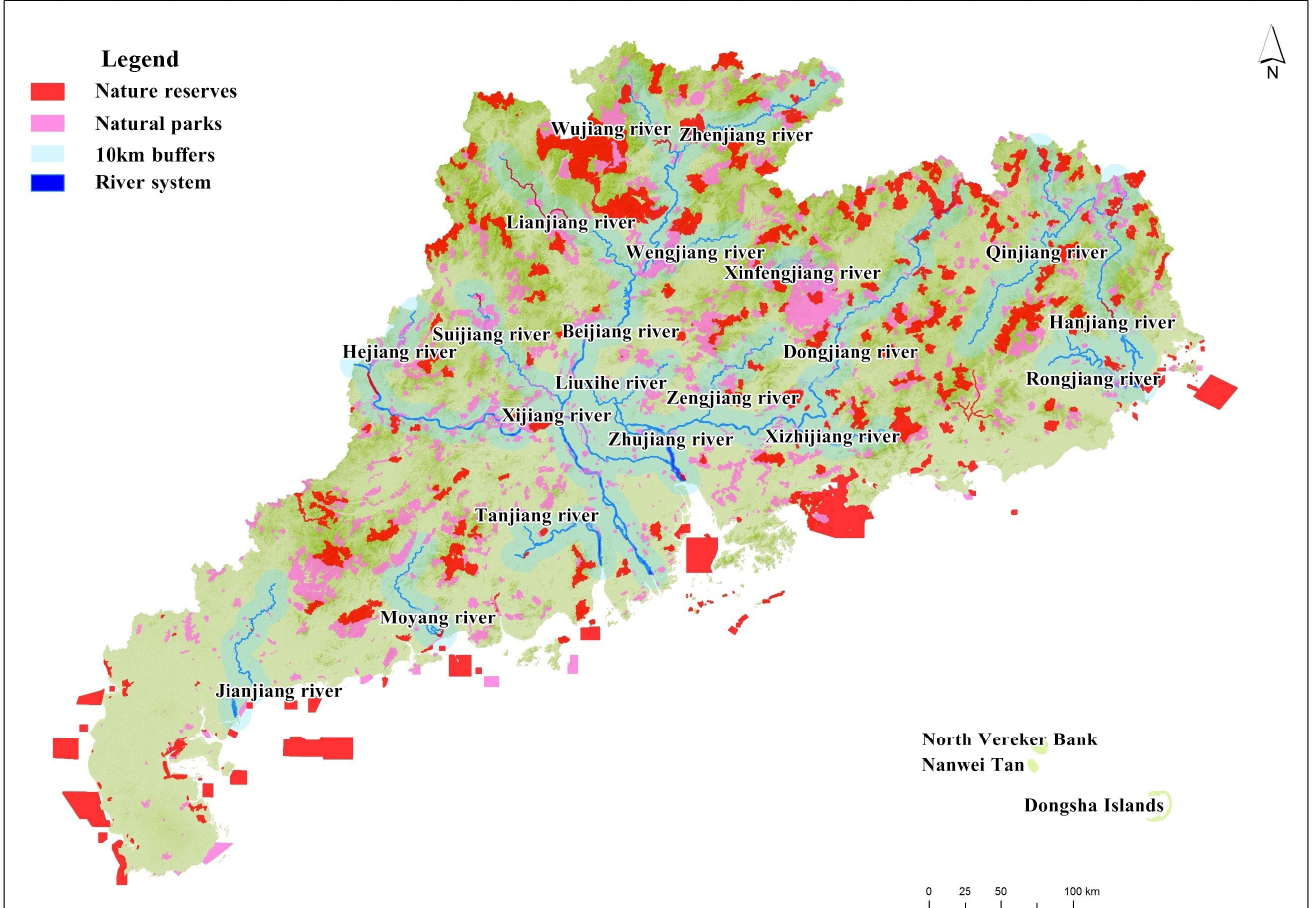
Figure 3. Spatial location relationship between NPAs and river basins.